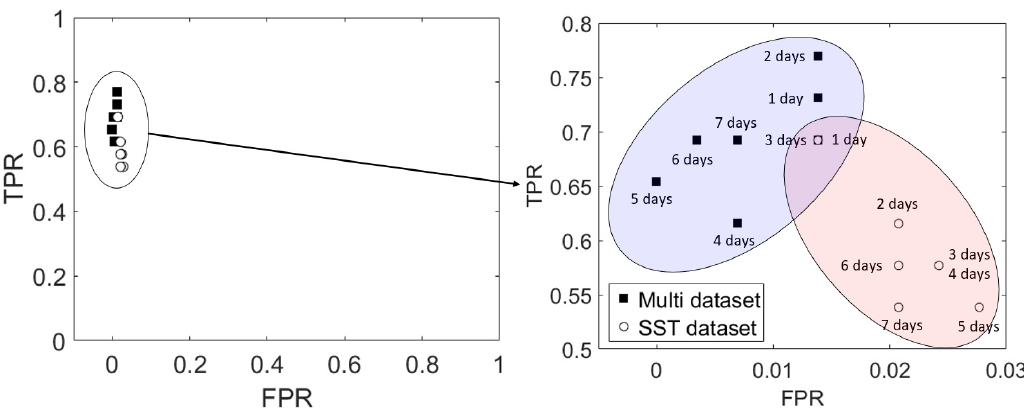
Figure 12. Receiver operating characteristic (ROC) space and plots of HWT occurrence predictions from 1 to 7 days using the true positive rate ( TPR ) and false positive rate ( FPR ) in area (a) for 2018.